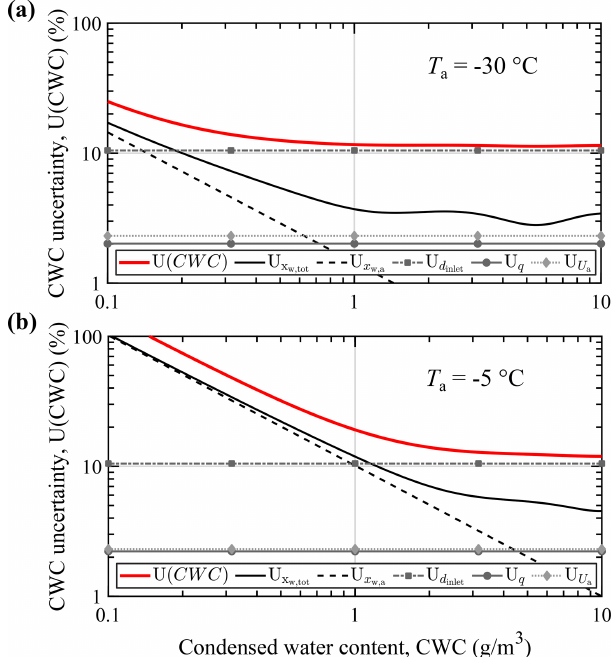
Figure 10. Condensed water content measurement uncertainty (95%) and individual contributions at static air temperatures of (a) − 30 ◦ C and (b) − 5 ◦ C. Uncertainties are given relative to the actual CWC and for isokinetic sampling. Wind speed and static air pressure are 60ms − 1 and 1013 . 25hPa, respectively. The ambient air is assumed to be fully saturated with respect to supercooled liq- uid.